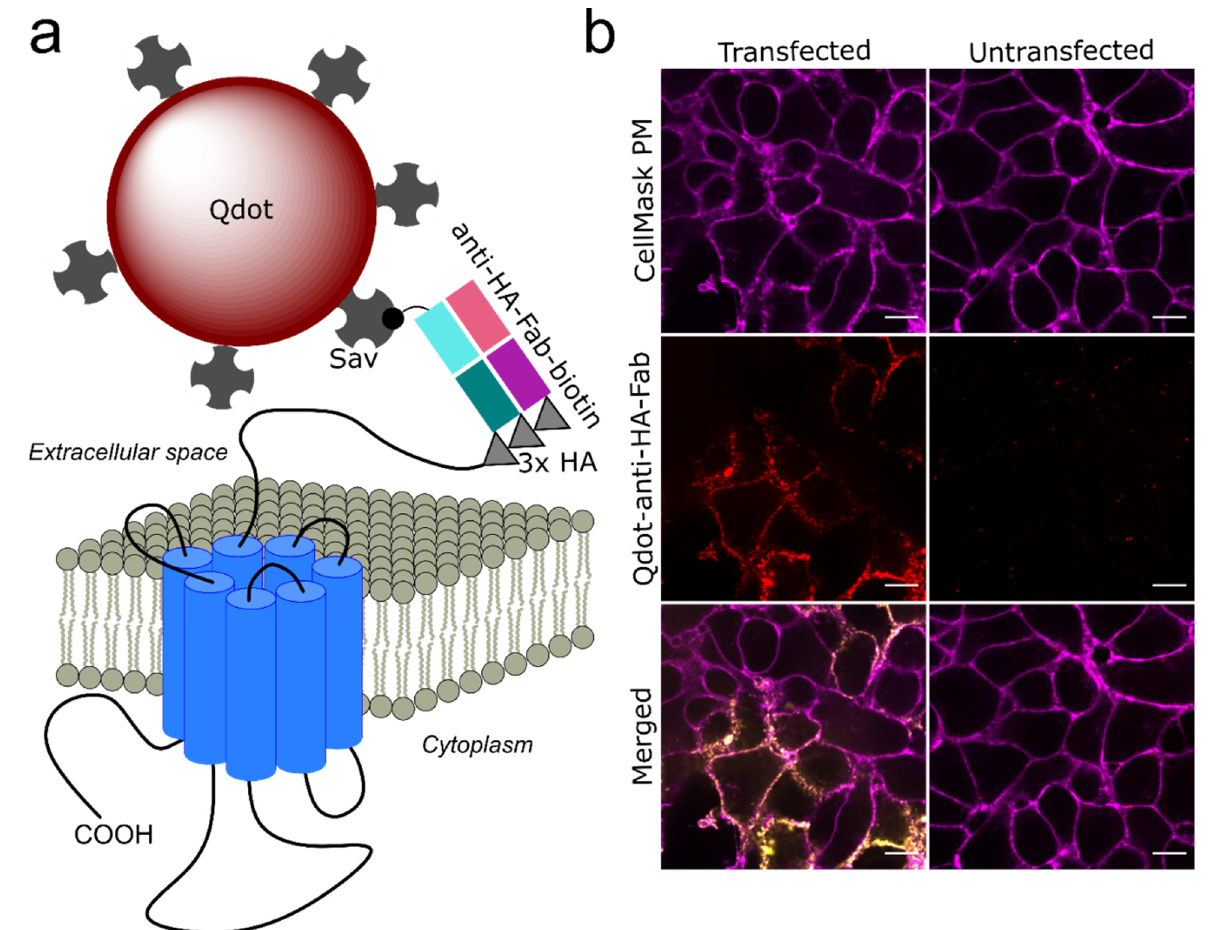
Figure 1 . Qdot labeling of HA-tagged D2L receptors. ( a ) Schematic of the labeling approach is shown here (drawn not to scale). Triple HA-tagged D2L receptors were labeled at the surface of transiently transfected HEK-293T cells with biotinylated anti-HA-Fab and streptavidin-conjugated Qdots; ( b ) Labeling specificity was confirmed by incubating transfected and untransfected HEK-293T cells with anti-HA-Fab-biotin/SavQdot655 in the presence of CellMask PM stain to show the outline and the relative focal plan of imaged cells. Scale bar: 10 μ m.